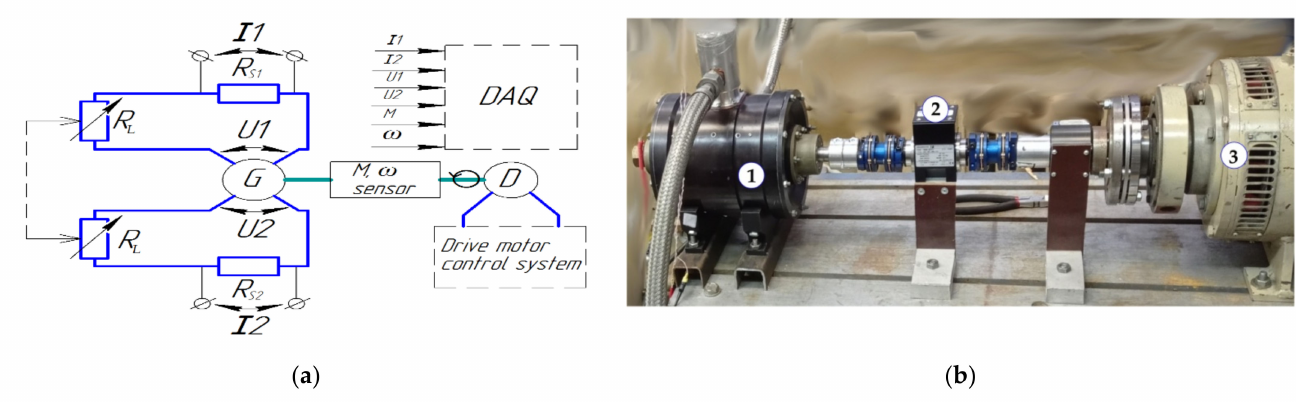
Figure 3. ( a ) Schematic of the test site; ( b ) Photo of the mechanical part of the bench. 1—HTS generator, 2—torque and rotation speed sensor, and 3—variable speed motor